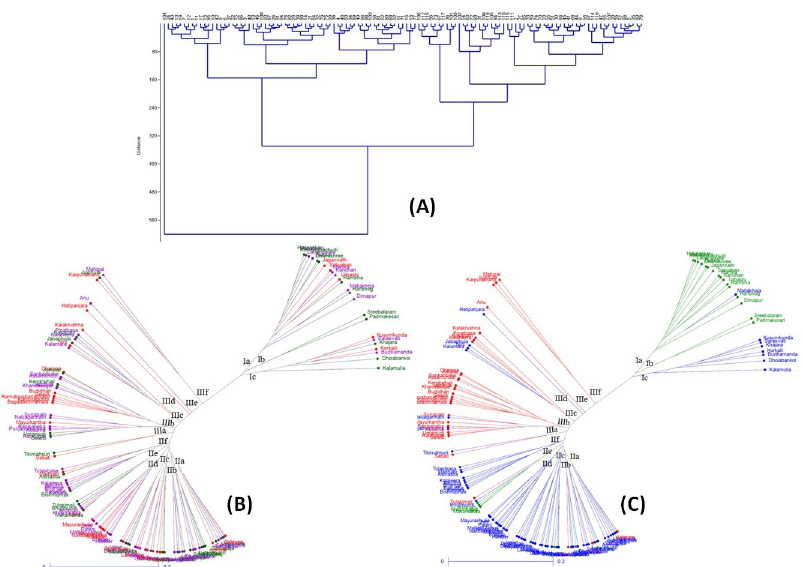
Fig 5. Clustering of 119 genotypes. (A) Ward’s Cluster diagram based on the nine morphological descriptors; (B) Dendrogram based on the genotypic data: green, violet, and red colors indicate tolerant, moderately tolerant, and susceptible genotypes respectively based on LBI in hydroponics condition; (C) Dendrogram based on the genotypic data: genotypes in red, green, and blue colors indicate membership in SP1, SP2, and SP3 based on population structure